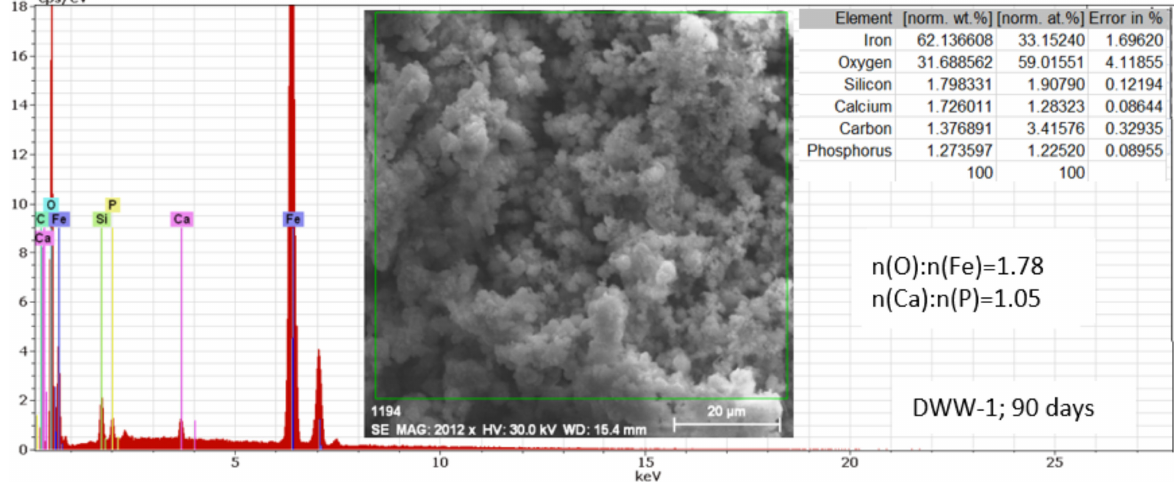
Figure 25. EDS results for the sample immersed for 90 days in DWW-1. The molar ratio O: Fe = 1.78 confirms that the corrosion product is a mixture of oxy- hydroxide (FeOOH) and ferric oxide (Fe 2 O 3 ) in which calcium phosphate is absorbed (molar ratio Ca: P = 1). The composition of the crust deposited on the nodular cast iron sample immersed for 90 days in DWW-2 is shown in Figure 26.